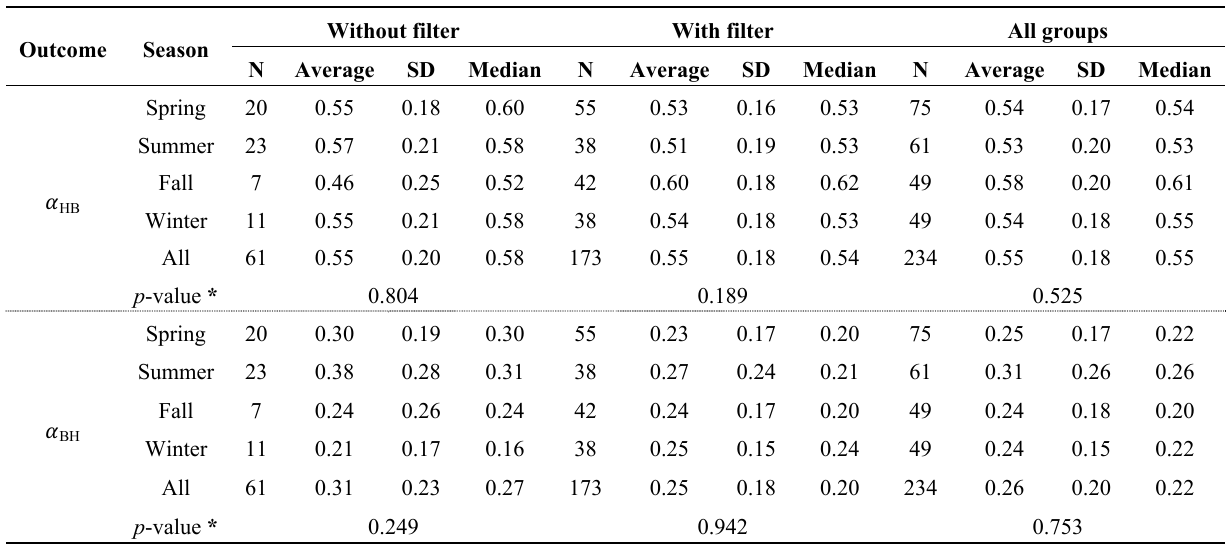
Table 3. Proportion of interzonal flows in the house and bedroom by season and intervention group. Without filter With filter All Outcome Season